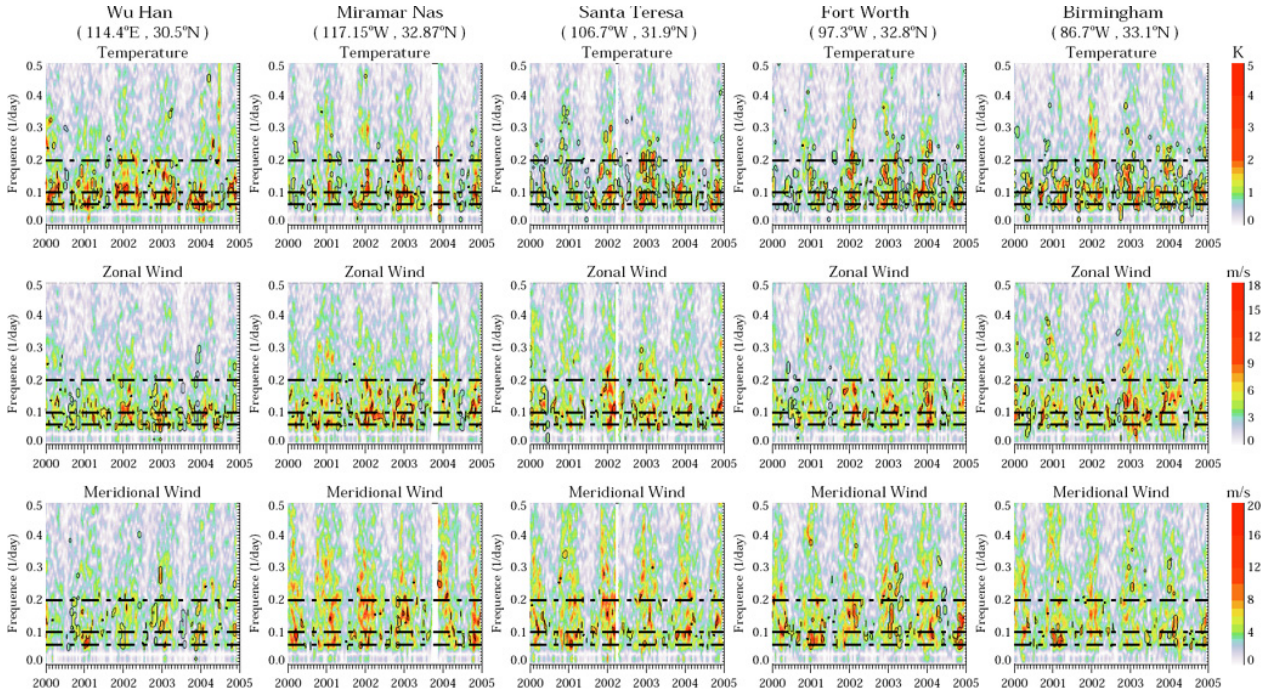
Fig. 3. Time-frequency cross-sections of the Lomb-Scargle spectral amplitudes of the temperature, zonal and meridional wind disturbances at 10km during 2000–2004. The dash-dotted lines in every panel denote the frequencies of the 5-, 10- and 16-day waves, respectively, from up to down. The significance of 90% confidence level is shown with black